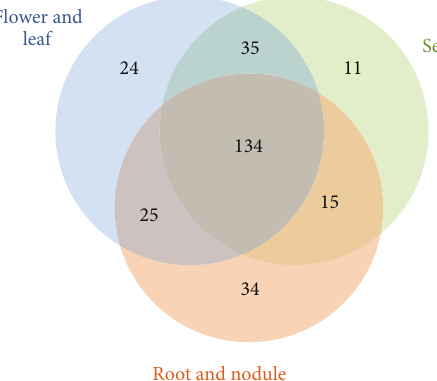
Figure 4: Summarized expression data for soybean bHLHs. 281 soybean bHLHs were found to be expressed. Root and nodule expression classes were combined as all, but 11 of the 150 nodule- expressed bHLHs were found to also be represented in the root class. Three of the total expressed bHLHs were detected only in pod wall tissues (see Additional File